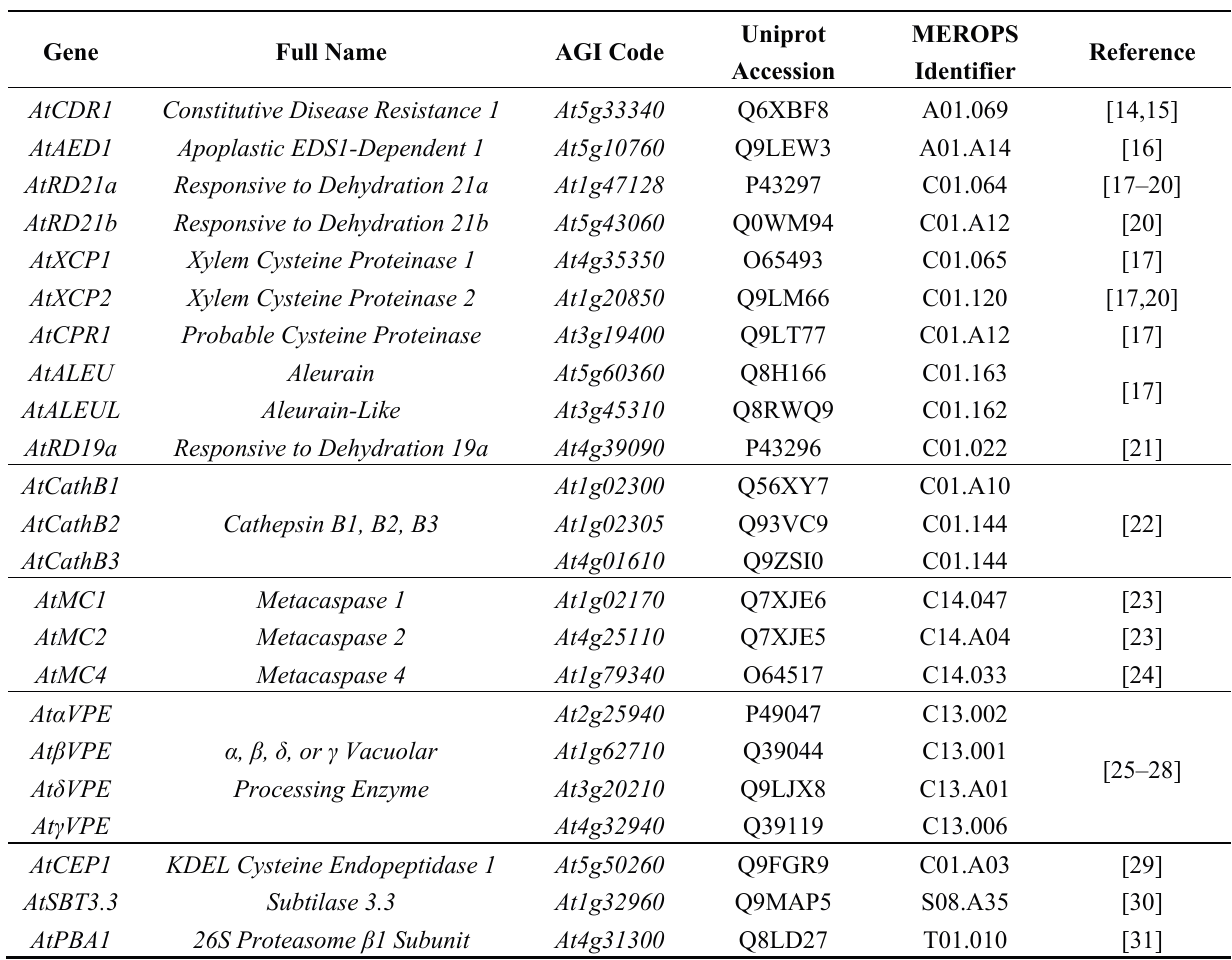
Table 1. Arabidopsis thaliana proteases whose functions in interactions with pathogens have been confirmed.